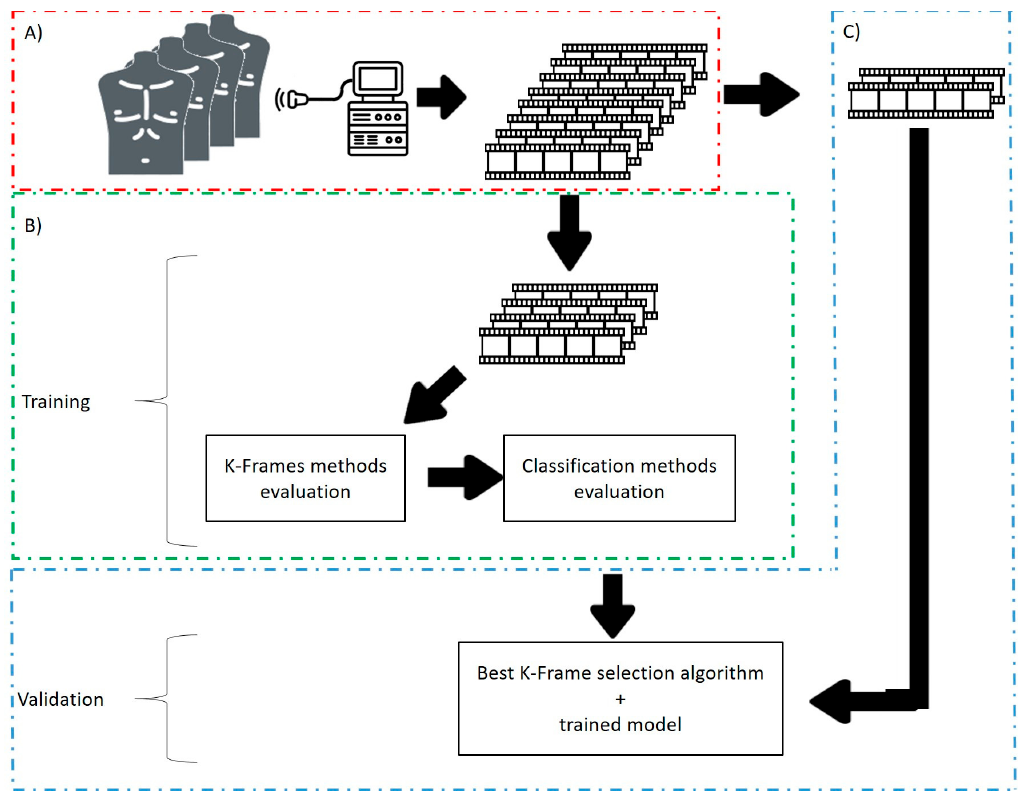
Figure 1. Main steps of the proposed work. ( A ) Data are acquired in the Emergency Department of the San Matteo Hospital to create a dataset of Lung UltraSound clips. ( B ) Part of these clips are selected as training set. These videos are also augmented to enlarge the training set. In this phase, different key-frames selection algorithm and classification techniques are evaluated. ( C ) The best key-frame selection algorithm and the best classifier are validated through the test